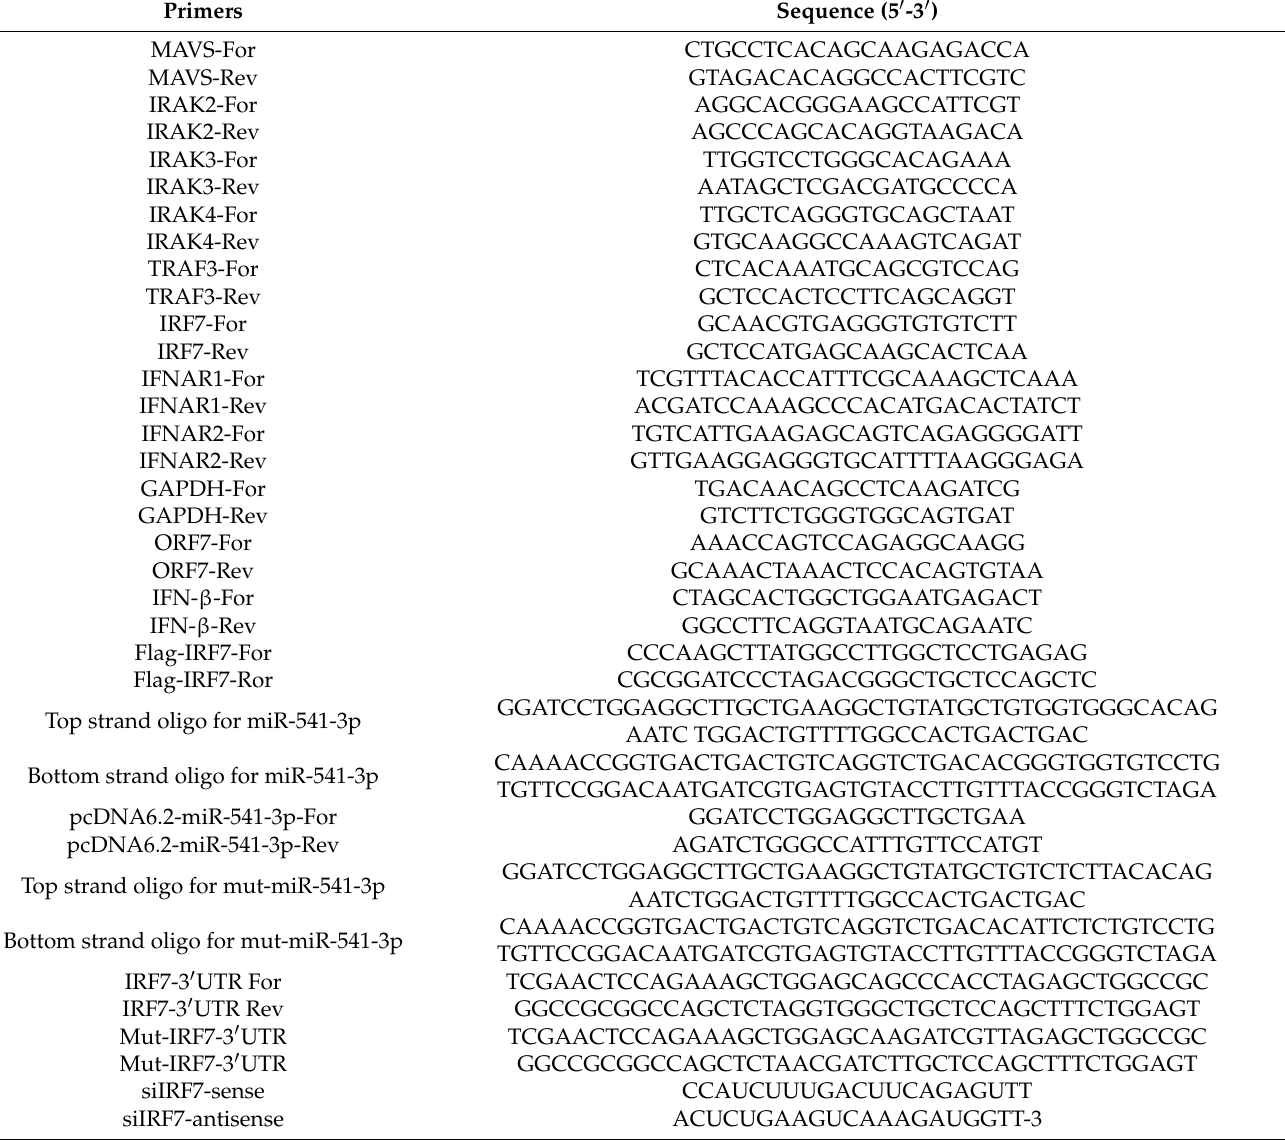
Table 1. Primers or oligonucleotides used in plasmid construction and quantitative real time poly- merase chain reaction